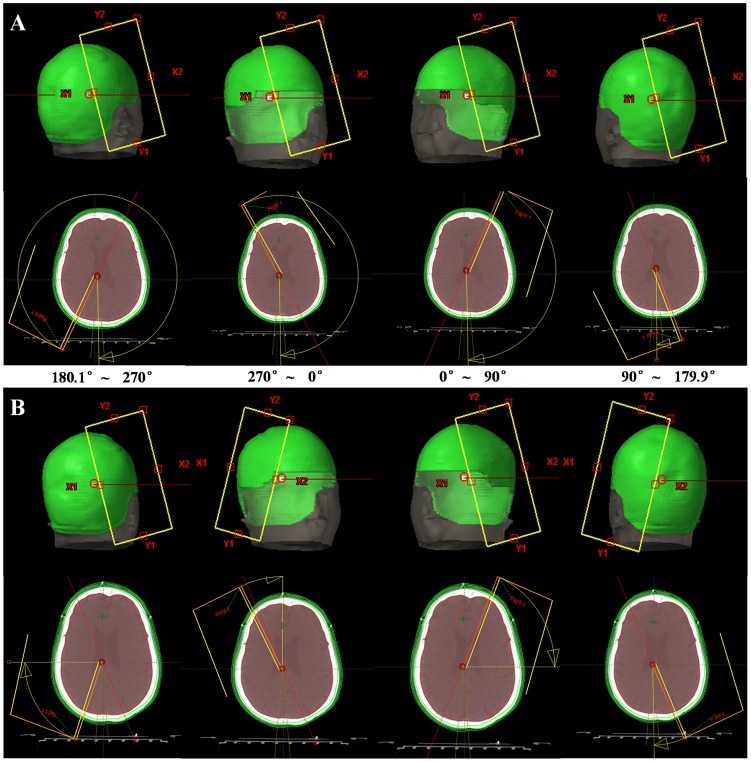

The beam setup of two designs for VMAT plans in clockwise (CW): (A) HFF-VMAT: two half-field full-arcs VMAT; (B) HFQ-VMAT: eight half-field quarter-arcs VMAT.